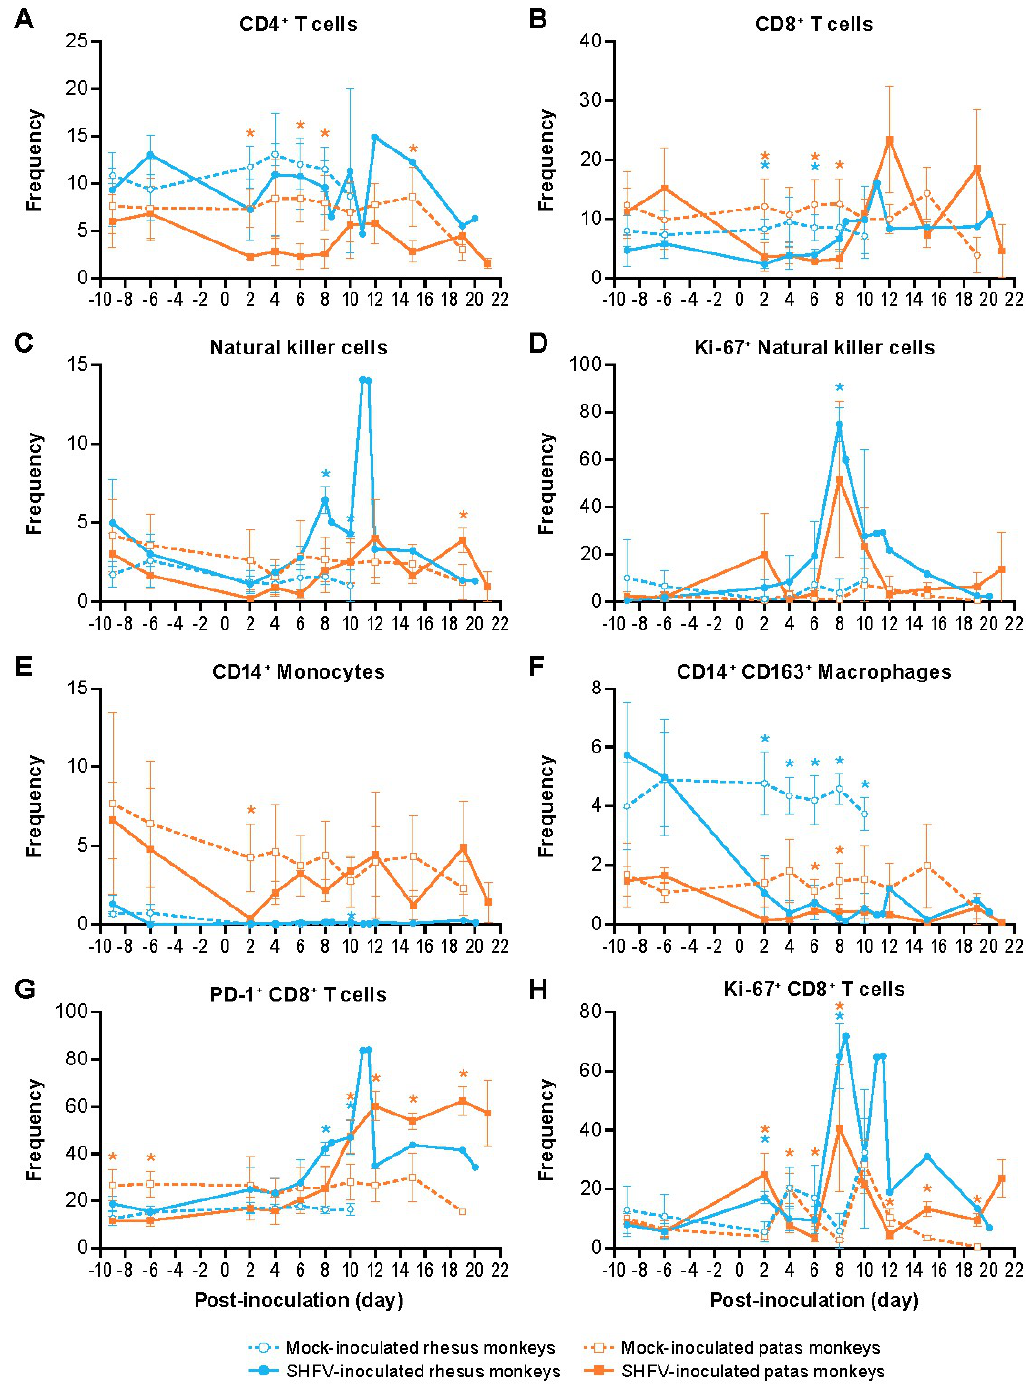
Figure 6. Circulating cell populations in SHFV-infected and mock-infected animals. The mean frequency of the indicated cell populations from whole blood of mock- (closed symbols) and SHFV-inoculated (open symbols) patas monkeys (orange) and rhesus monkeys (blue) ( A – F ). The error bars represent standard deviation. * symbols represent p < 0.05 and are colored according to species. IgG antibody responses were detected by enzyme-linked immunosorbent assay (ELISA) in all three SHFV-inoculated patas monkeys and two of the three (the survivor and one non-survivor) SHFV-inoculated rhesus monkeys (Figure 7). Two SHFV-inoculated patas monkeys had detectable